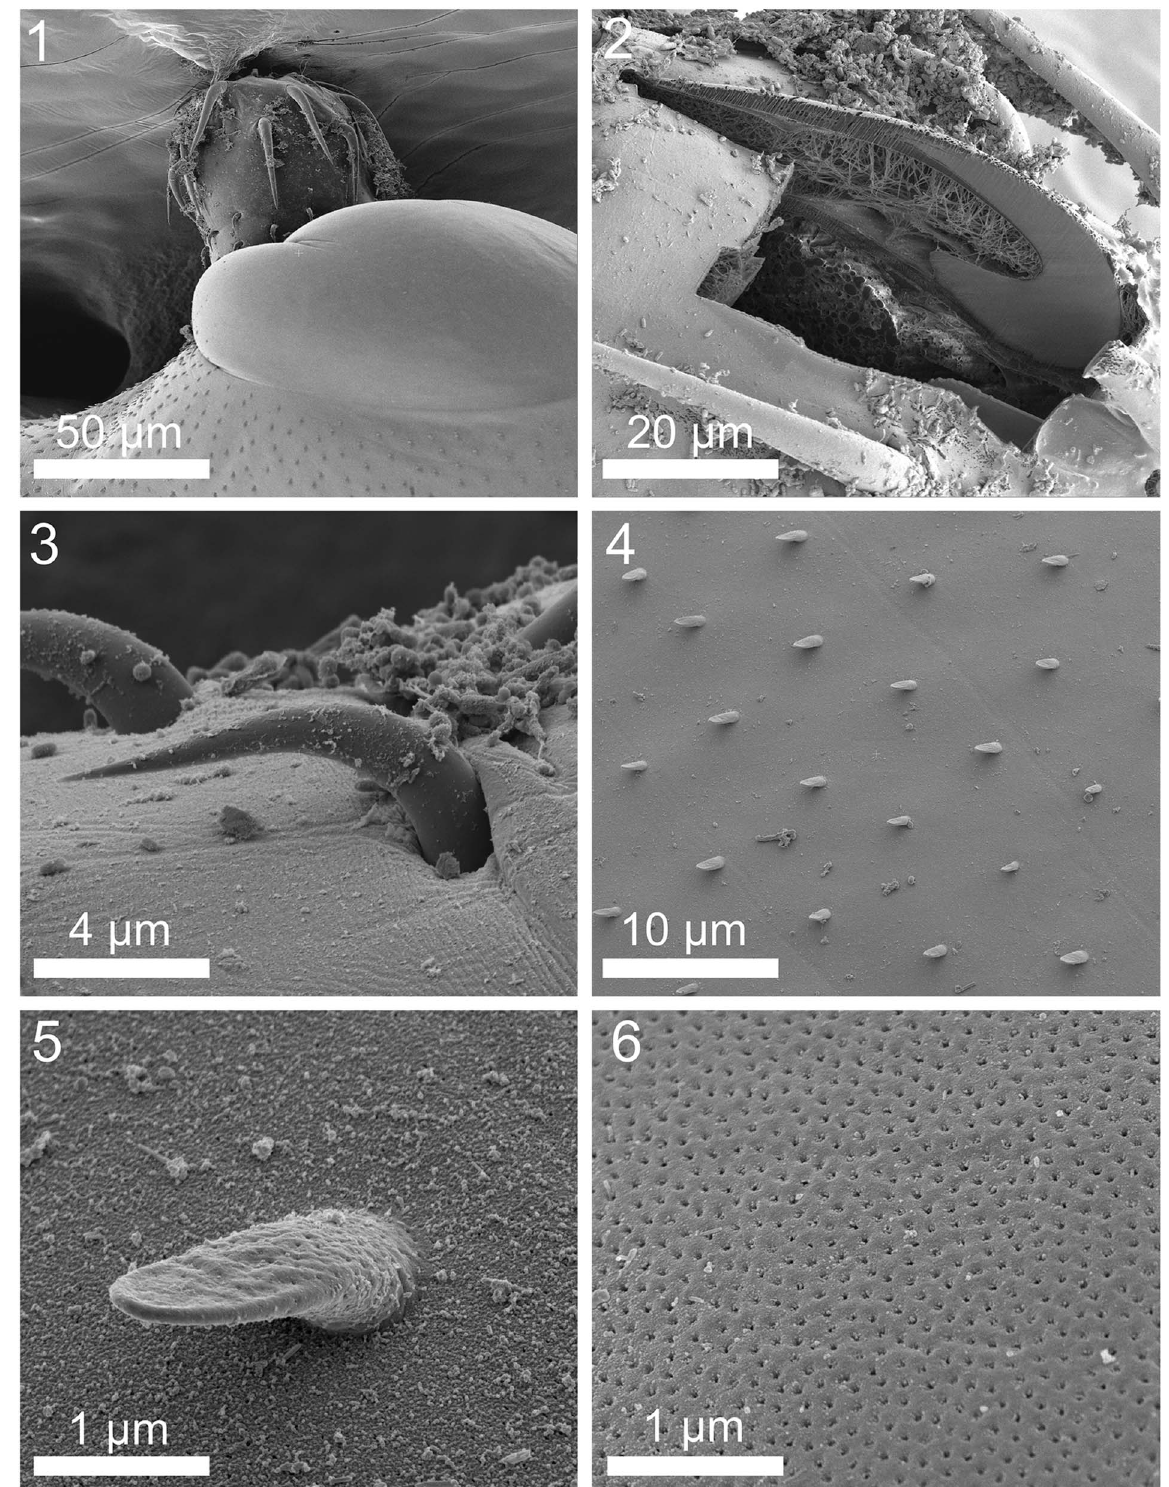
Figures 1 – 6. SEM of specimens of Heterosentis holospinus from Leiognathus equulus from Vietnam. (1) The anterior part of a worm showing the proboscis, the spineless anterior trunk cone, and the anterior part of the spiny trunk. (2) A longitudinal Gallium cut section of the anterior hook. Note the thickness of the hook layers and the relationship between the hook and the size and shape of the root. (3) Posterior hooks of the proboscis. (4) A general view of trunk spines and their pattern of distribution. (5) A high magni fi cation of a typical duck-bill- shaped trunk spine showing a continuation of trunk micropores. (6) Micropores in a mid-section of the